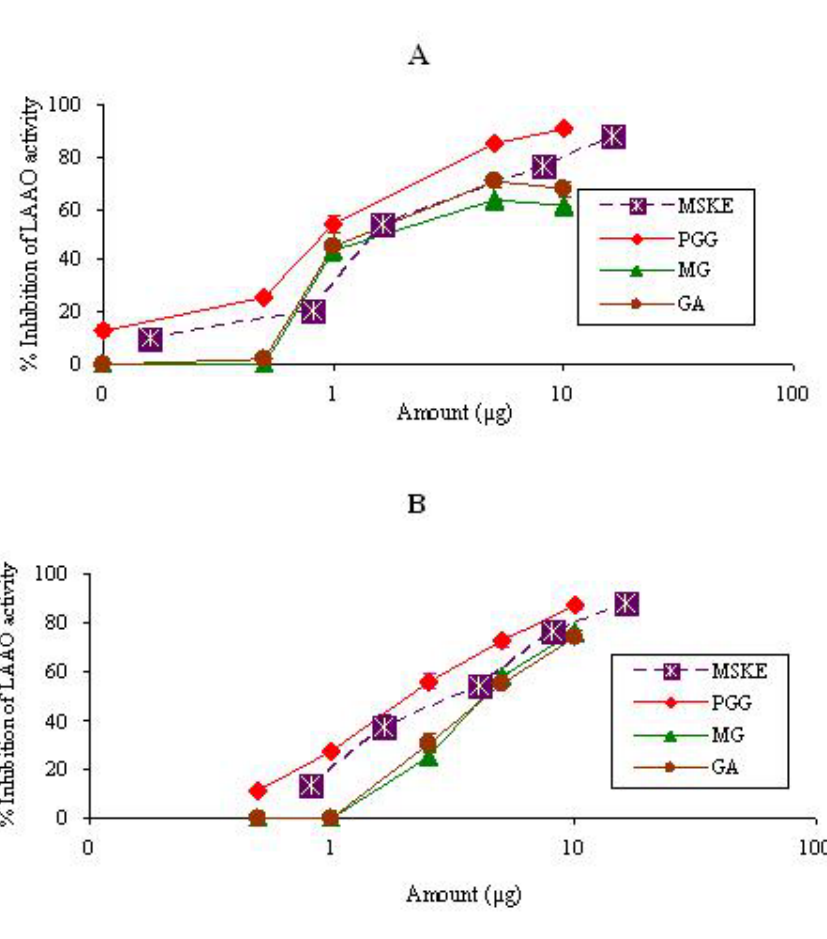
Figure 3. Semi-log plot of inhibition of LAAO activity of CR (50 µg) (A) and NK (50 µg) (B) venoms by MSKE and its phenolic principles (GA, MG and PGG). Values are mean ± S.E.M. of duplicate